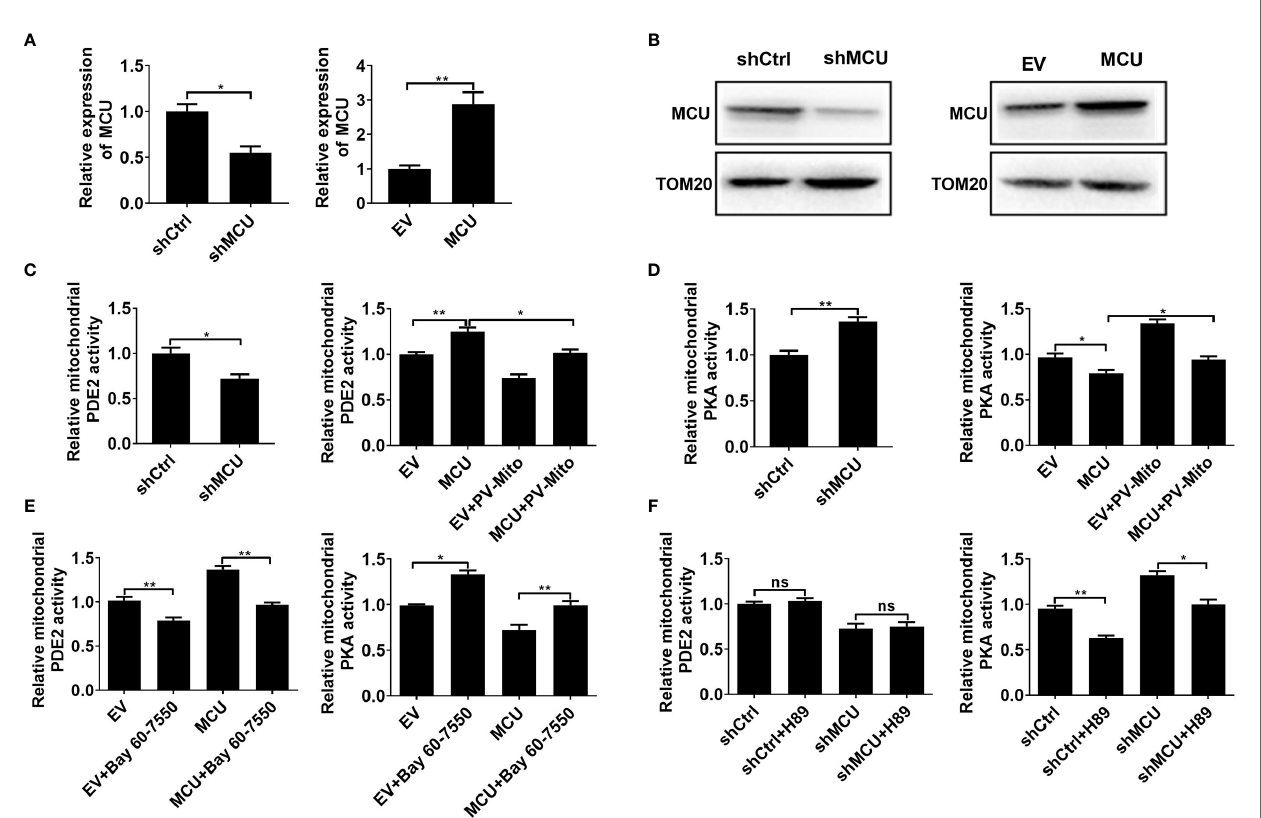
FIGURE 1 | MCU-mediated mitochondrial Ca2+ uptake activates mitochondrial PDE2 to inhibit mitochondrial PKA activity. (A) QRT-PCR analysis for the mRNA level in LS174T cells treated as indicated. (B) Western blot analysis of protein level of mitochondrial MCU in LS174T cells treated as indicated. (C) Relative mitochondrial PDE2 activity in LS174T cells treated as indicated. (D) Relative mitochondrial PKA activity in LS174T cells treated as indicated. (E) Relative activities of mitochondrial PDE2 and PKA in LS174T cells treated as indicated (Bay 60-7550, 4.7nM PDE2 inhibitor for 24h). (F) Relative activities of mitochondrial PDE2 and PKA in LS174T cells treated as indicated (H89, 1 m M PKA inhibitor for 24h). MCU, expression vector encoding mitochondrial calcium uniporter; shCtrl, expression vector encoding control shRNA; shMCU, expression vector encoding shRNA against MCU; EV, empty vector; PV-Mito, expression vector encoding parvalbumin with mitochondria target sequence. *P < 0.05; **P < 0.01; ns, not signi fi